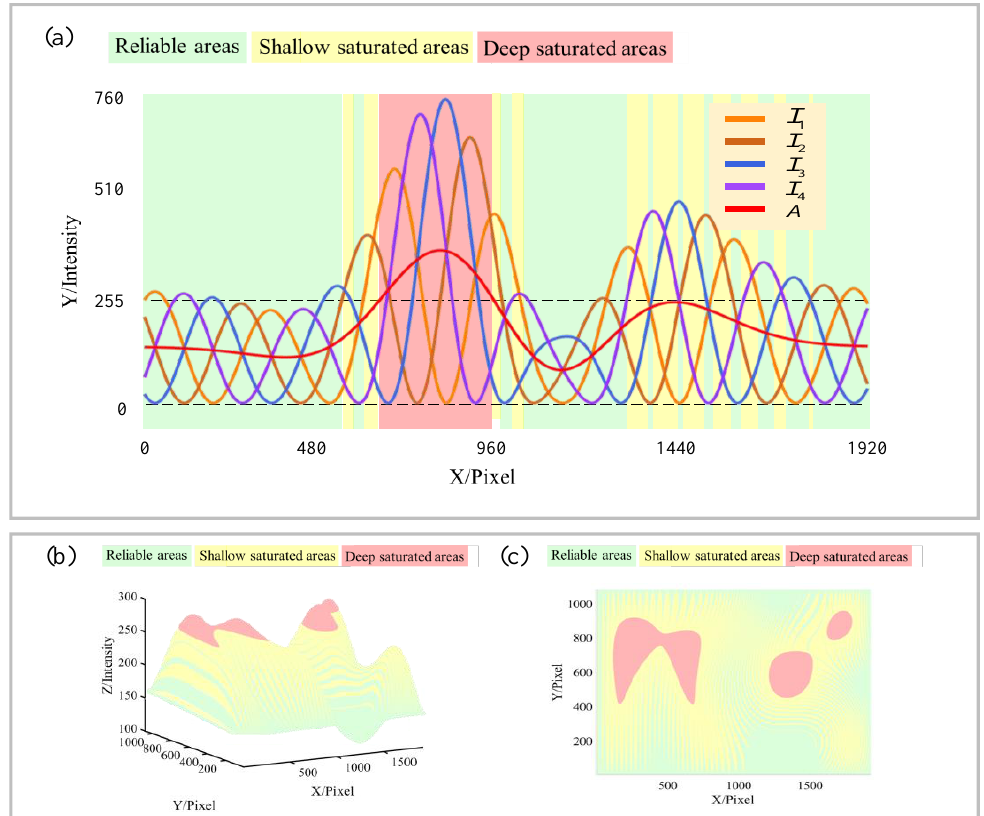
Figure 3. Examples of divisions of reliable area, shallow saturated area, and deep saturated area. ( a ) Example of one-dimensional area division. Panels ( b , c ) are examples of two-dimensional area division. Panel ( c ) is the top view of ( b ). All subgraphs use green, yellow, and red to represent reliable areas, shallow saturated areas, and deep saturated areas, respectively.